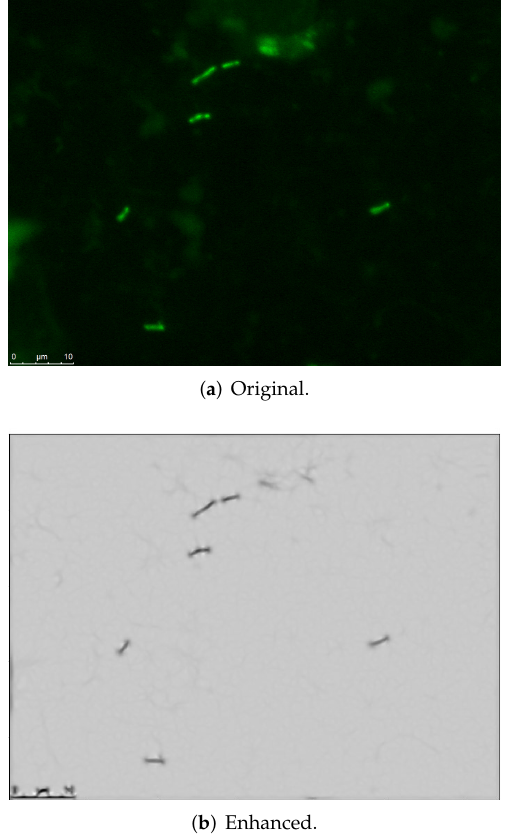
Figure 2. ( a ) Example of the typical fluorescence microscopic image used, and ( b ) the corresponding enhanced